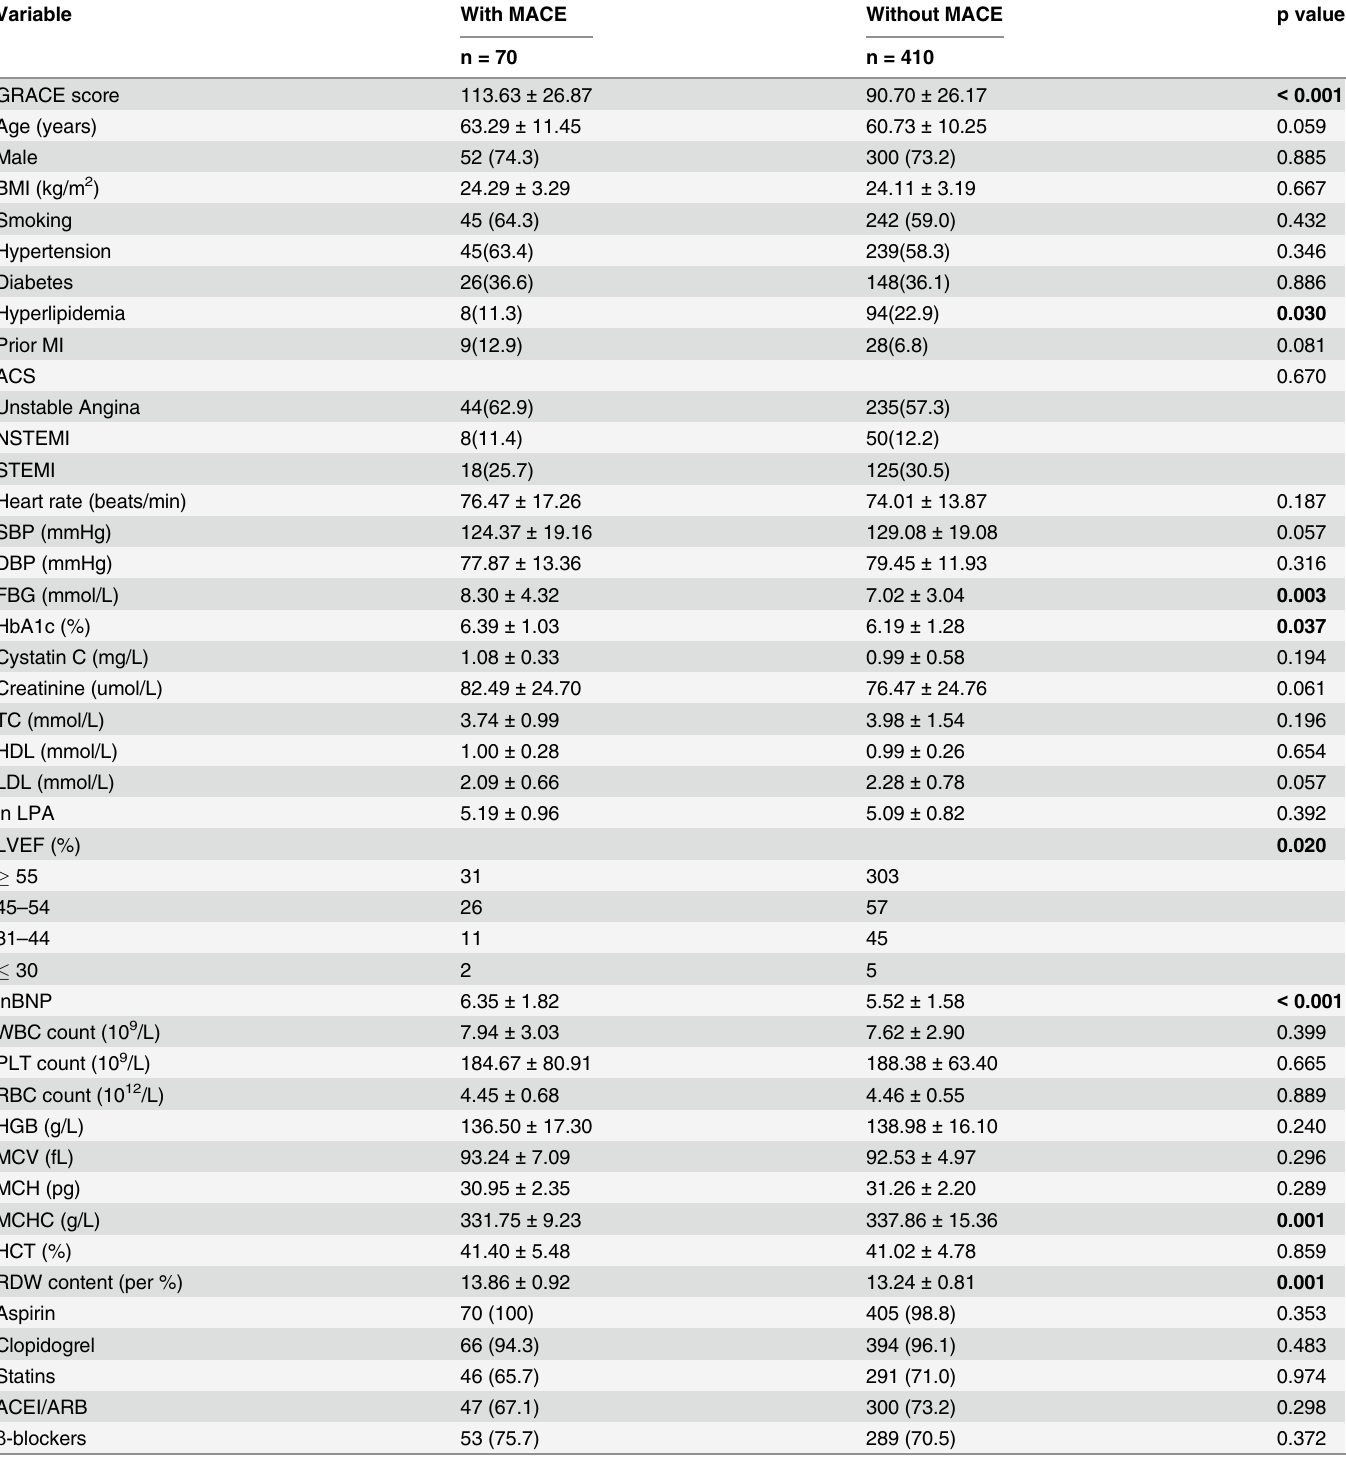
Table 2. Characteristics of acute coronary syndrome patients undergoing percutaneous intervention (PCI) with or without a major adverse cardiac event (MACE).